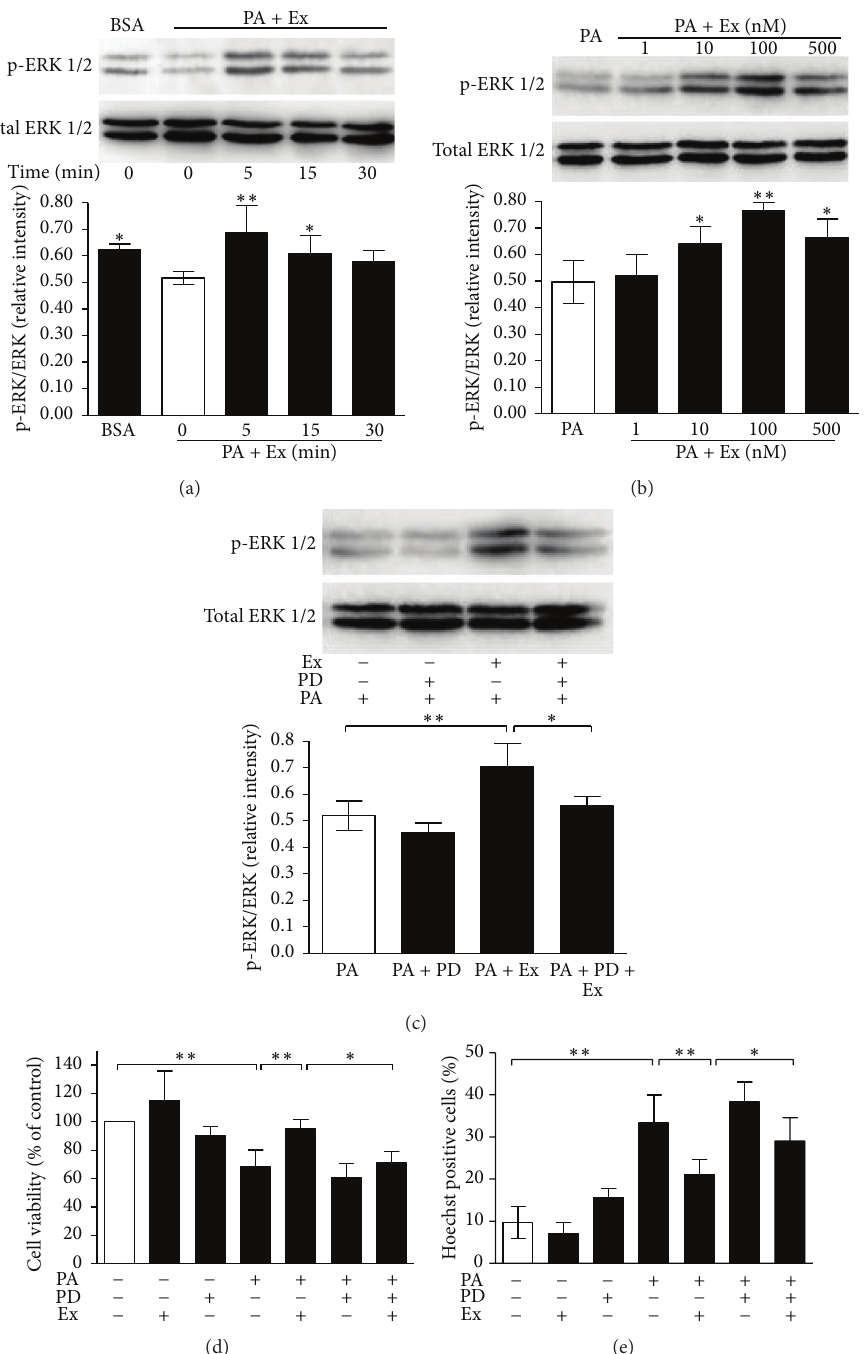
Figure 2: The antilipotoxic effects of exendin-4 on cell survival and apoptosis involve ERK1/2 pathway. MIN6 cells were preincubated overnight in serum-free DMEM and then incubated in serum-free DMEM containing 0.5% BSA (BSA) or 0.4 mM palmitate added 0.5% BSA (PA) for 24 h. Increasing concentrations (1–500nM) of exendin-4 (Ex) were used to treat the cells for the indicated times. (a) Total ERK1/2 and p-ERK1/2 protein expression after 0–30 min of treatment with 100nM Ex. Values are expressed as relative intensity ratio and represent the mean ± SE of three independent experiments. ∗ 𝑝 < 0.05 , ∗∗ 𝑝 < 0.01 , versus PA + Ex at 0 min. (b) Total ERK1/2 and p-ERK1/2 protein expression after 5 min of treatment with increasing concentrations (1–500nM) of Ex. Values are expressed as relative intensity ratio and represent the mean ± SE of three independent experiments. ∗ 𝑝 < 0.05 , ∗∗ 𝑝 < 0.01 , versus PA group without Ex. (c) Total ERK1/2 and p-ERK1/2 protein expression after 5 min of treatment with 100 nM Ex, with or without inhibitor. Before Ex stimulation, cells with PA were pretreated for 30 min with ERK1/2 inhibitor, 50 𝜇 M PD98059 (PD). Values are expressed as relative intensity ratio and represent the mean ± SE of three independent experiments. ∗ 𝑝 < 0.05 , ∗∗ 𝑝 < 0.01 . (d) Cell survival was assessed by MTT assay. ∗ 𝑝 < 0.05 , ∗∗ 𝑝 < 0.01 . (e) apoptosis assessed by Hoechst33258 staining. MIN6 cells were incubated with BSA or PA, with or without PD, in the presence or absence of 100nM Ex, in serum-free medium for 24 h. Values of survival are expressed as percentage of control (cells treated with BSA alone) and represent the mean ± SE of five independent experiments. Values of apoptosis are expressed as percentage of apoptotic cells and represent the mean ± SE of 10 random fields of vision of three independent experiments. ∗ 𝑝 < 0.05 , ∗∗ 𝑝 < 0.01